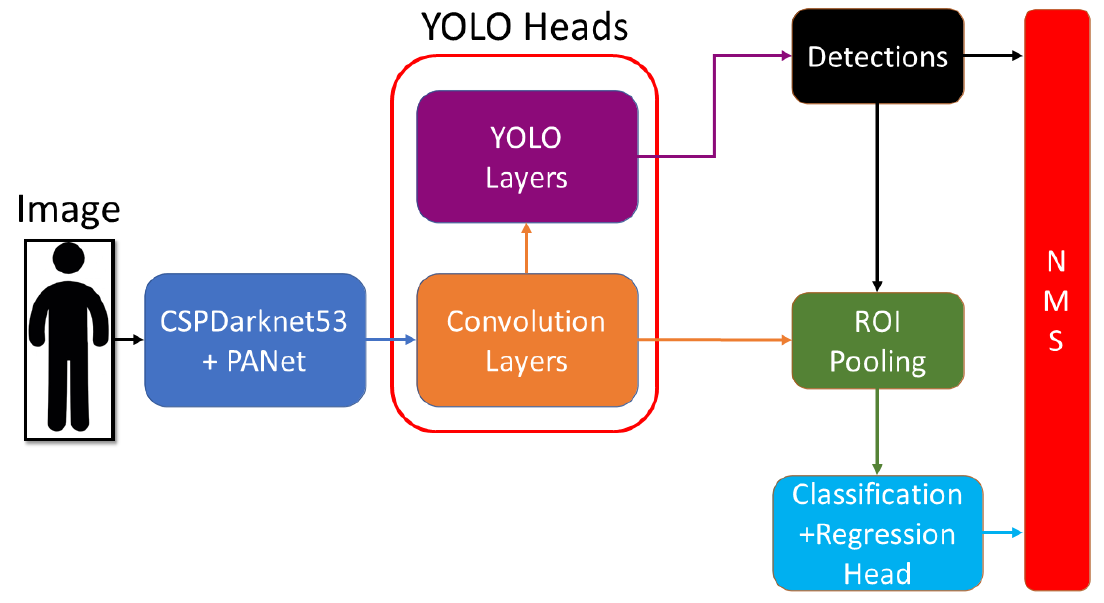
Figure 10. The proposed architecture of the system, based on 3 different YOLO Heads; each head contributes separately to the detection and ROI pooling part.